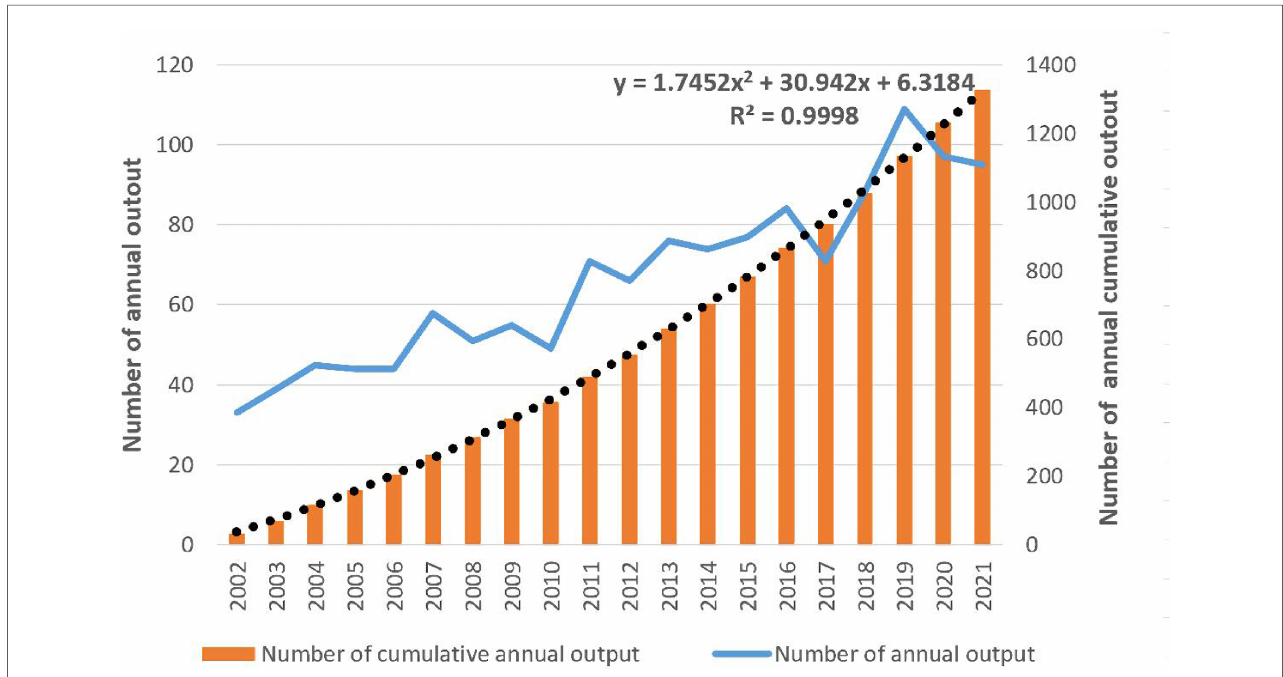
FIGURE 2 Trend chart of the number of publications on pediatric bronchiectasis between 2003 and 2022.